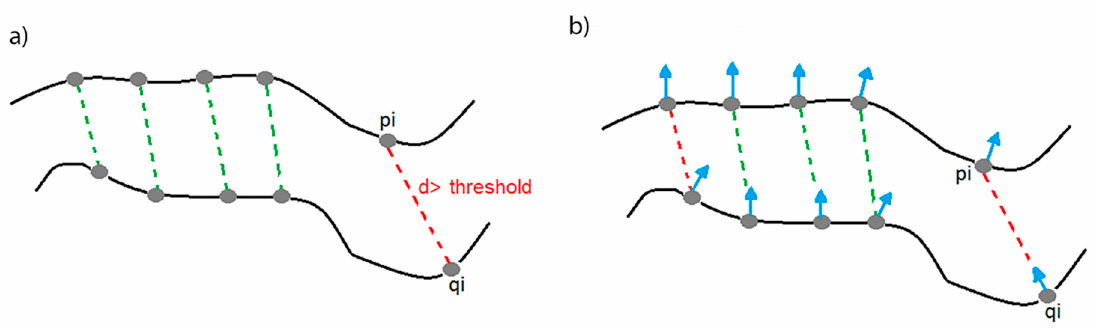
Figure 7. Method for filtering correspondences with ICP algorithm: ( a ) method based on distance; ( b ) method based on normal vectors, which application was discarded.